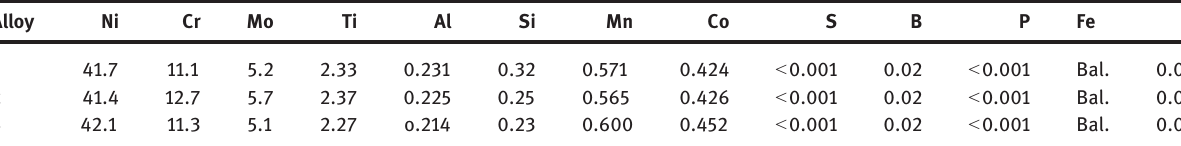
Table 1: Chemical compositions of Incoloy 901 alloys with various amounts of carbon (wt%).